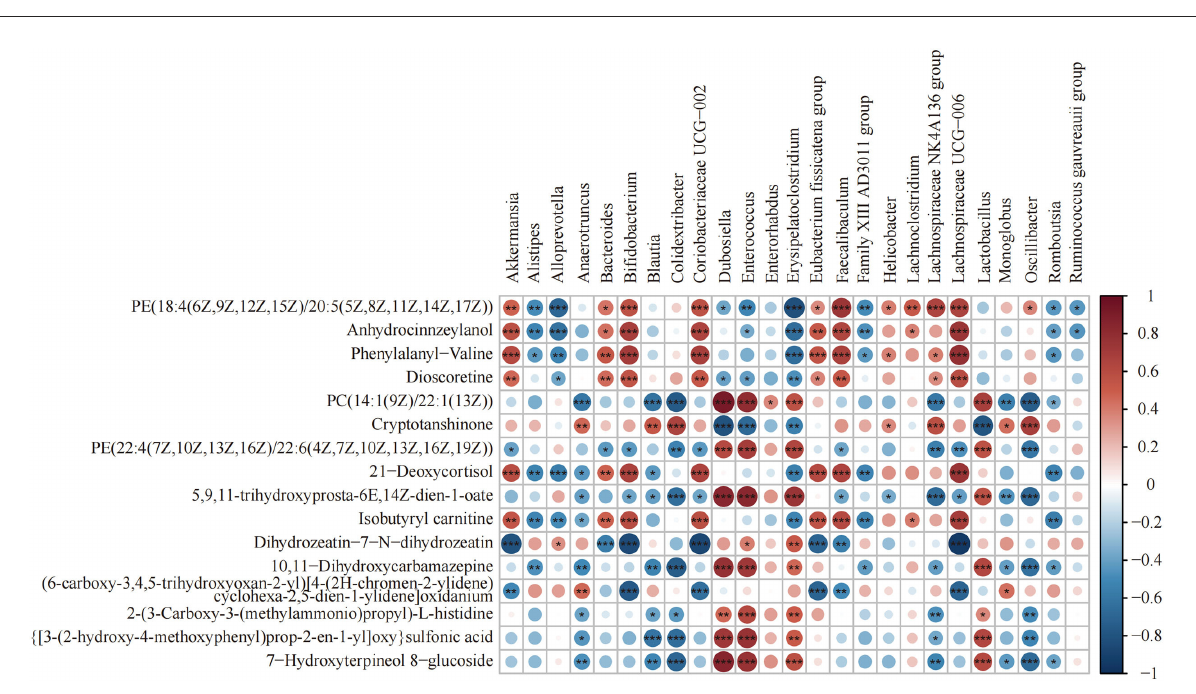
FIGURE7 Heat map of the correlation between differential bacteria of the gut microbiota and differential metabolites ( n = 8). Differential genera and their abundance in the four groups of colonic contents samples were obtained by LEfSe analysis. Differential metabolites were obtained from the NC and HFD groups and the MSDF and HSDF groups for comparison. * p < 0.05; ** p < 0.01; *** p <